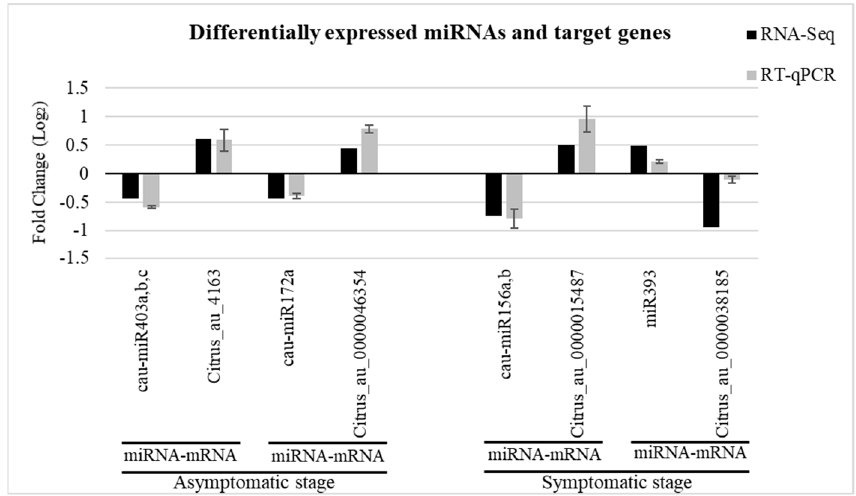
Figure 3. Experimental validation of the differentially expressed miRNAs and target genes by RT- qPCR. For RT-qPCR quantification, each bar represents relative expression levels calculated by 2 ⁻ ΔΔ Ct method. Error bars represent standard deviation of two biological replicates.